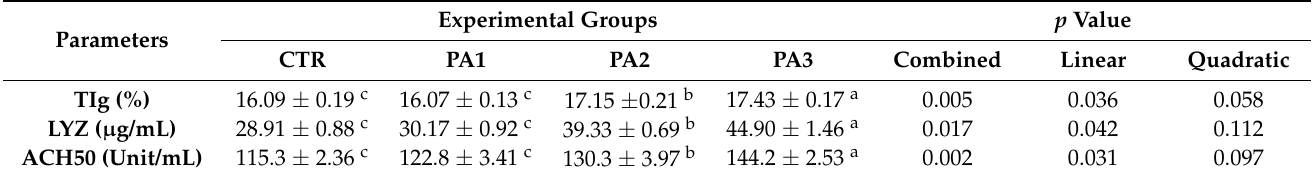
Table 7. The effects of P. australis extract (0, 100, 200, and 400 mg extract/kg diet) dietary administra- tion on serum immune indices of common carp for 56 days ( n =